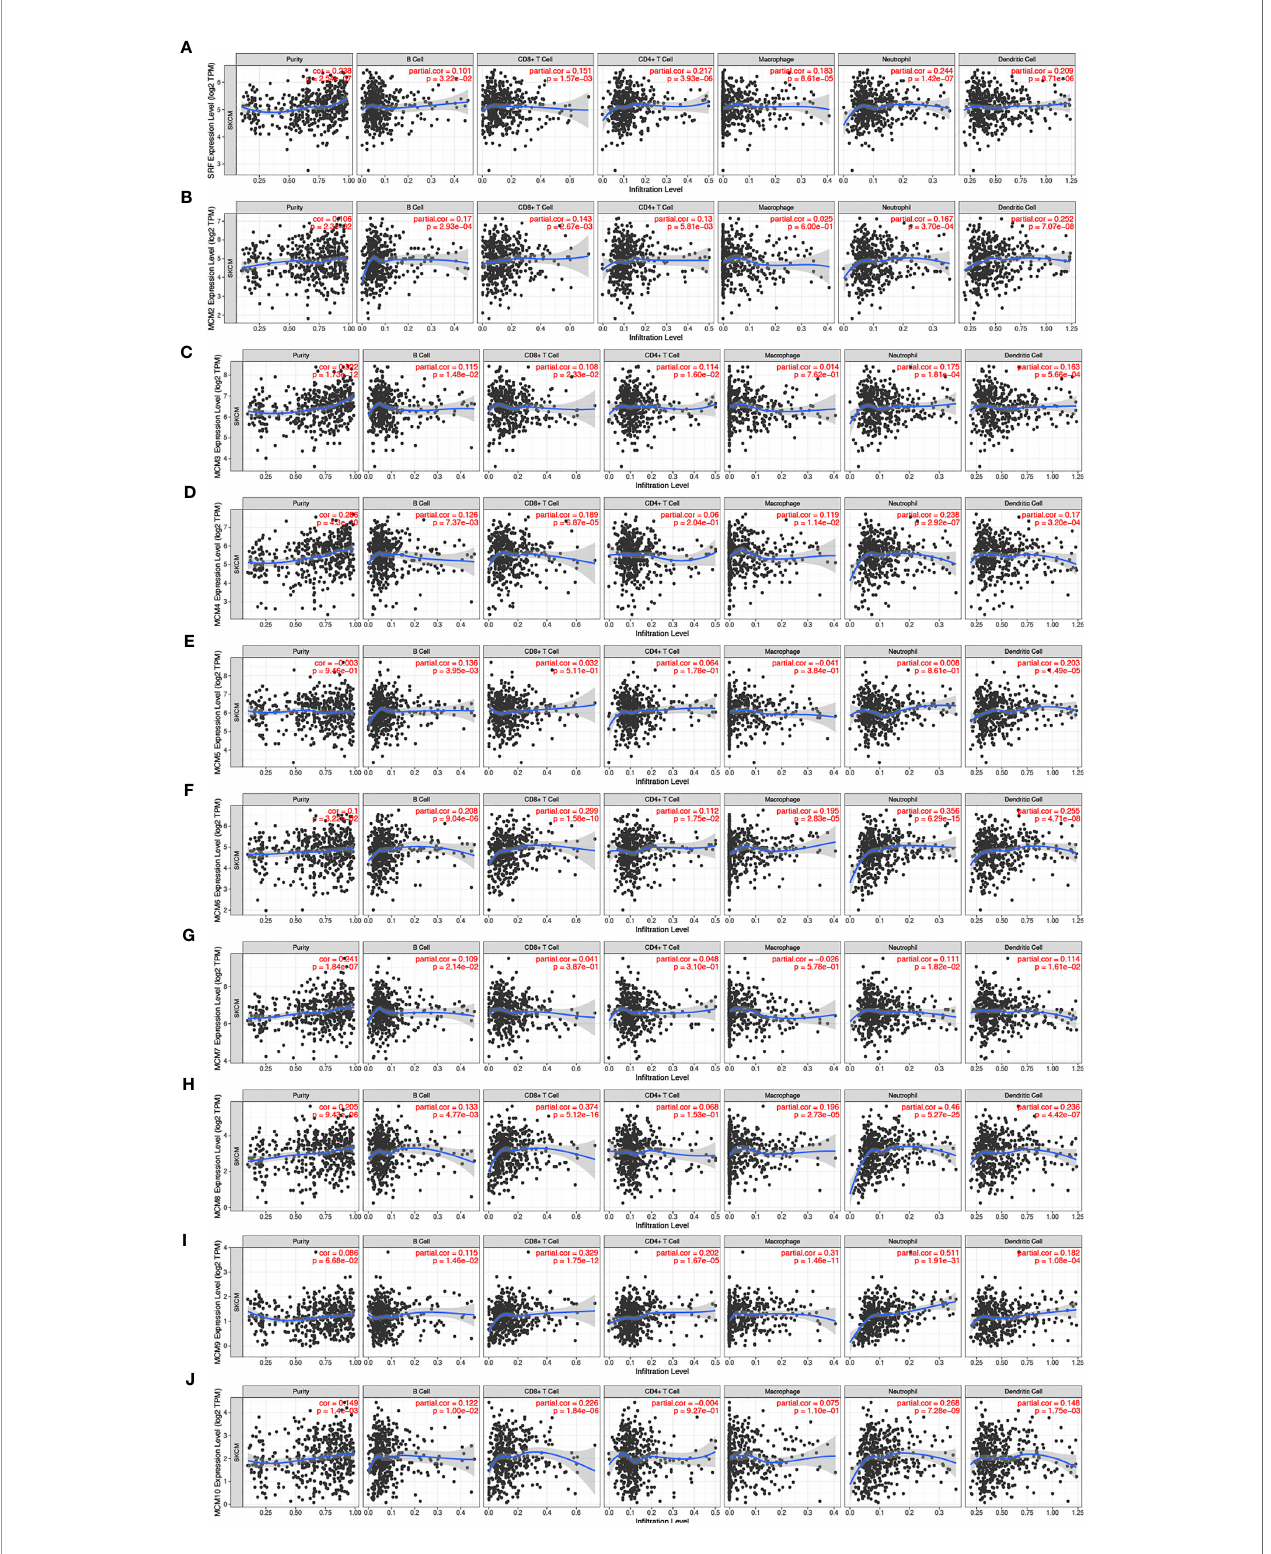
FIGURE 11 | (A – J) The correlation between different expressed MCM s and immune cell in fi ltration (TIMER). There was a positive correlation between MCM1/2/3/7/ 8/10 expression and the in fi ltration of immune cells. Instead, MCM4/5/6/9 were negatively associated with the in fi ltration of immune